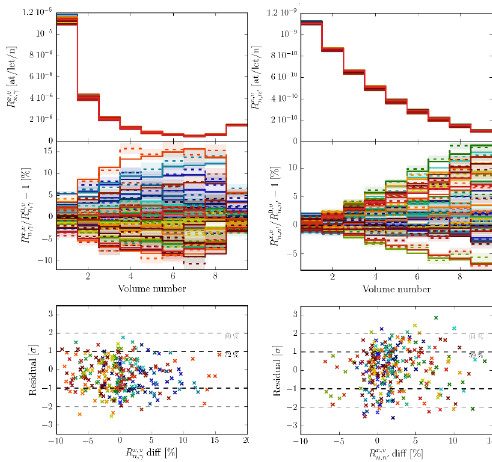
Figure 6. Reaction rate distributions (top) for the capture (left) and inelastic (right) reactions; relative variations with one color per random cross section of the classic TENDL library (second line) with the TMC-CS in plain lines and the TMC-Ref in dashed lines; and residuals (bottom)